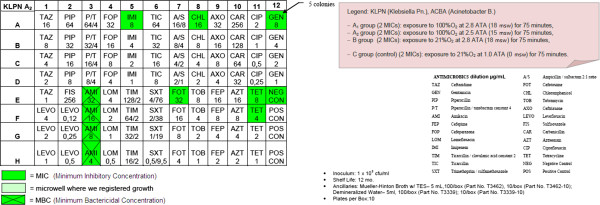
KLPN plate exposed to 100% O2at 2.5 ATA.